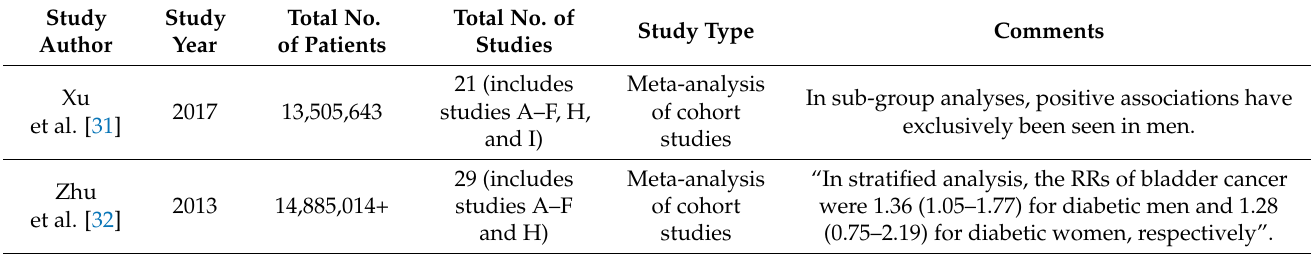
Table 3. Diabetes mellitus and the incidence of bladder